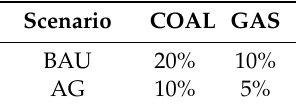
Table 2. The reserve capacity of coal-fired units and gas-fired units under the BAU and AG reserve capacity adjustment